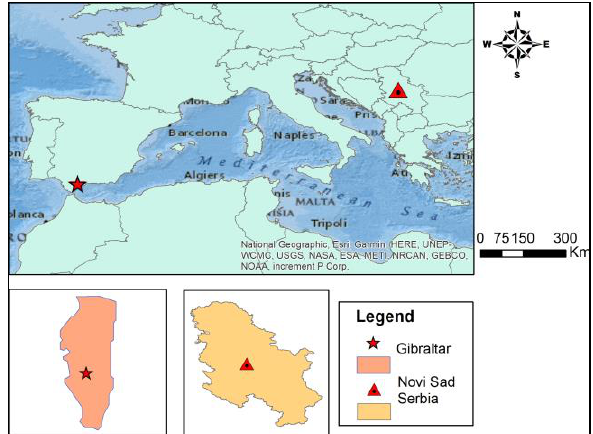
Figure 1. Locations of Gibraltar and Novi Sad Serbia test sites.